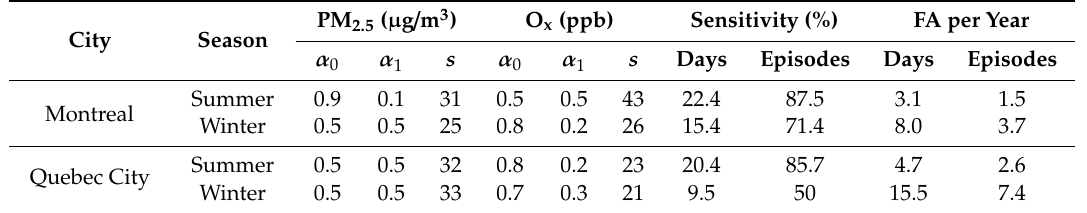
Table 3. Results for indicator weightings and thresholds for Montreal and Quebec. FA = false alarm.